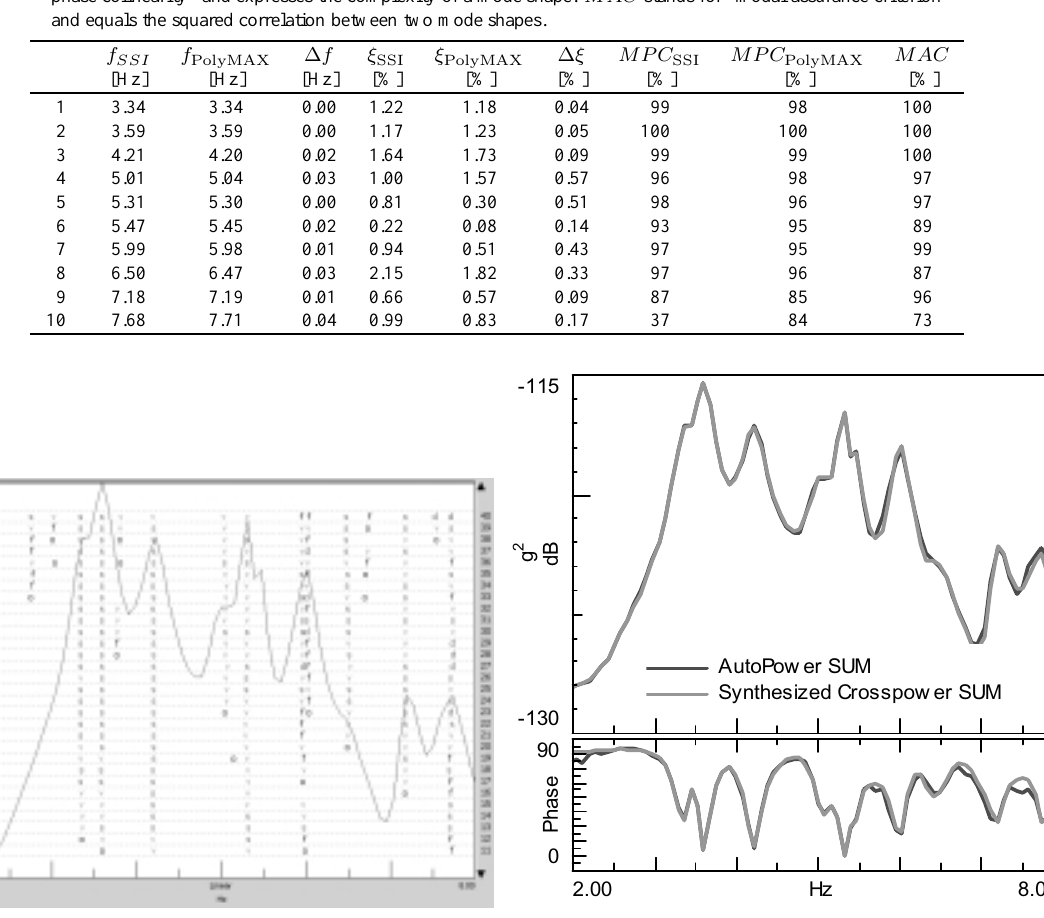
Fig. 9. Empty stadium: (Left) stabilisation diagram obtained by applying PolyMAX; (Right) sum of measured (red/black) versus synthesised PolyMAX spectra (green/grey). the rank [32]. Therefore, plotting the singular values as a function of frequency yields the eigenfrequencies as local maxima. The method is also able to detect closely spaced modes: more than one singular value will reach a local maximum around the close eigenfrequencies. The first singular vector at resonance is an estimate of the mode shape at that frequency. In case of mode multiplicity at a resonance frequency, every singular vector corresponding to a non-zero singular value is considered as a mode shape